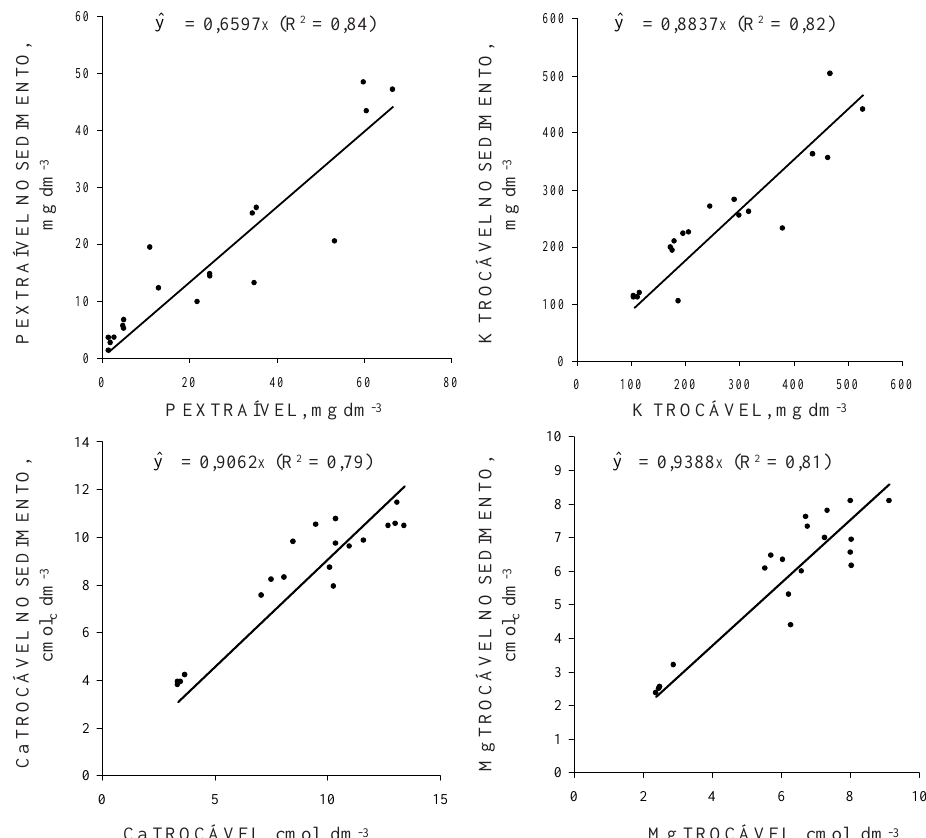
Mg TROCÁVEL, cmol c dm -3 Ca TROCÁVEL, cmol c dm -3 Figura 1. Regressão linear simples das concentrações de fósforo extraível (P) e potássio (K), cálcio (Ca) e magnésio (Mg) trocáveis na camada de 0–0,025 m do solo com os respectivas concentrações nos sedimentos transportados pela erosão hídrica, em diferentes sistemas de manejo de um Nitossolo Háplico alumínico cultivado com milho e feijão (quatro determinações no cultivo do milho e 15 no feijão).